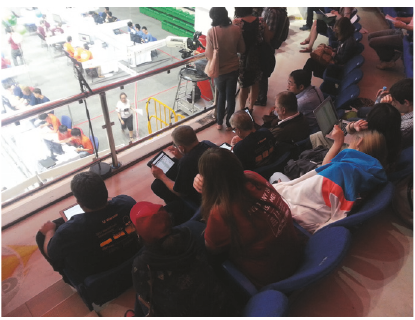
Figure 20: Local audience using MyICPC.